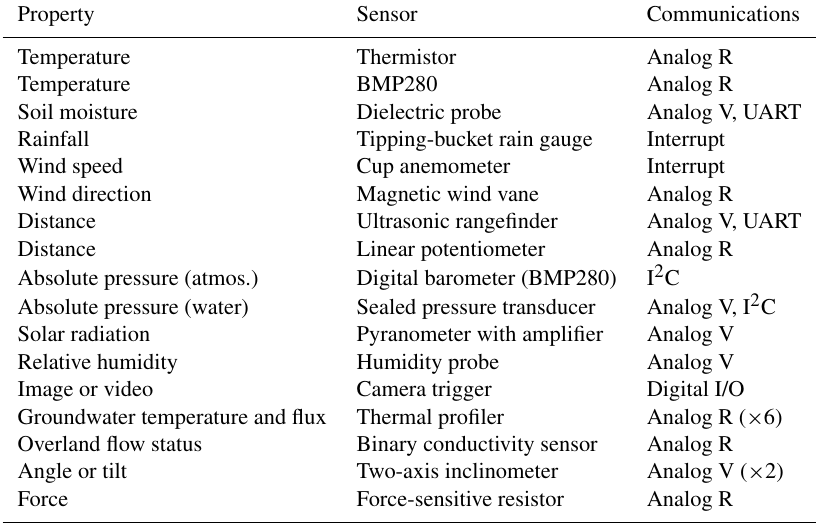
Table 3. Measurements and sensors currently supported by the ALog. Support for additional sensors may be added to the open-source ALog firmware library (Wickert et al., 2018a), following the _sensor_function_template example, which may be found in the design files and reference manual in the